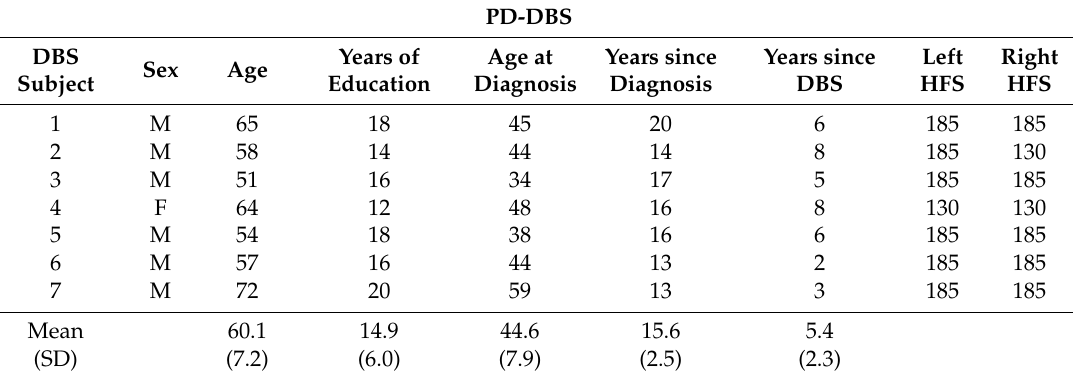
Table 1. Demographic characteristics of the individuals with DBS who provided speech samples under three di ff erent DBS frequency conditions. Males are identified as M, the female as F. Age is in years. HFS frequencies are in Hz and represent the clinical values for each subject. LFS frequency was 60 Hz in all cases. The durations of DBS treatment ranged from two to eight years. The sample size was a function of eligibility criteria (e.g., native language, handedness) and consent for multiple evaluations under di ff erent DBS